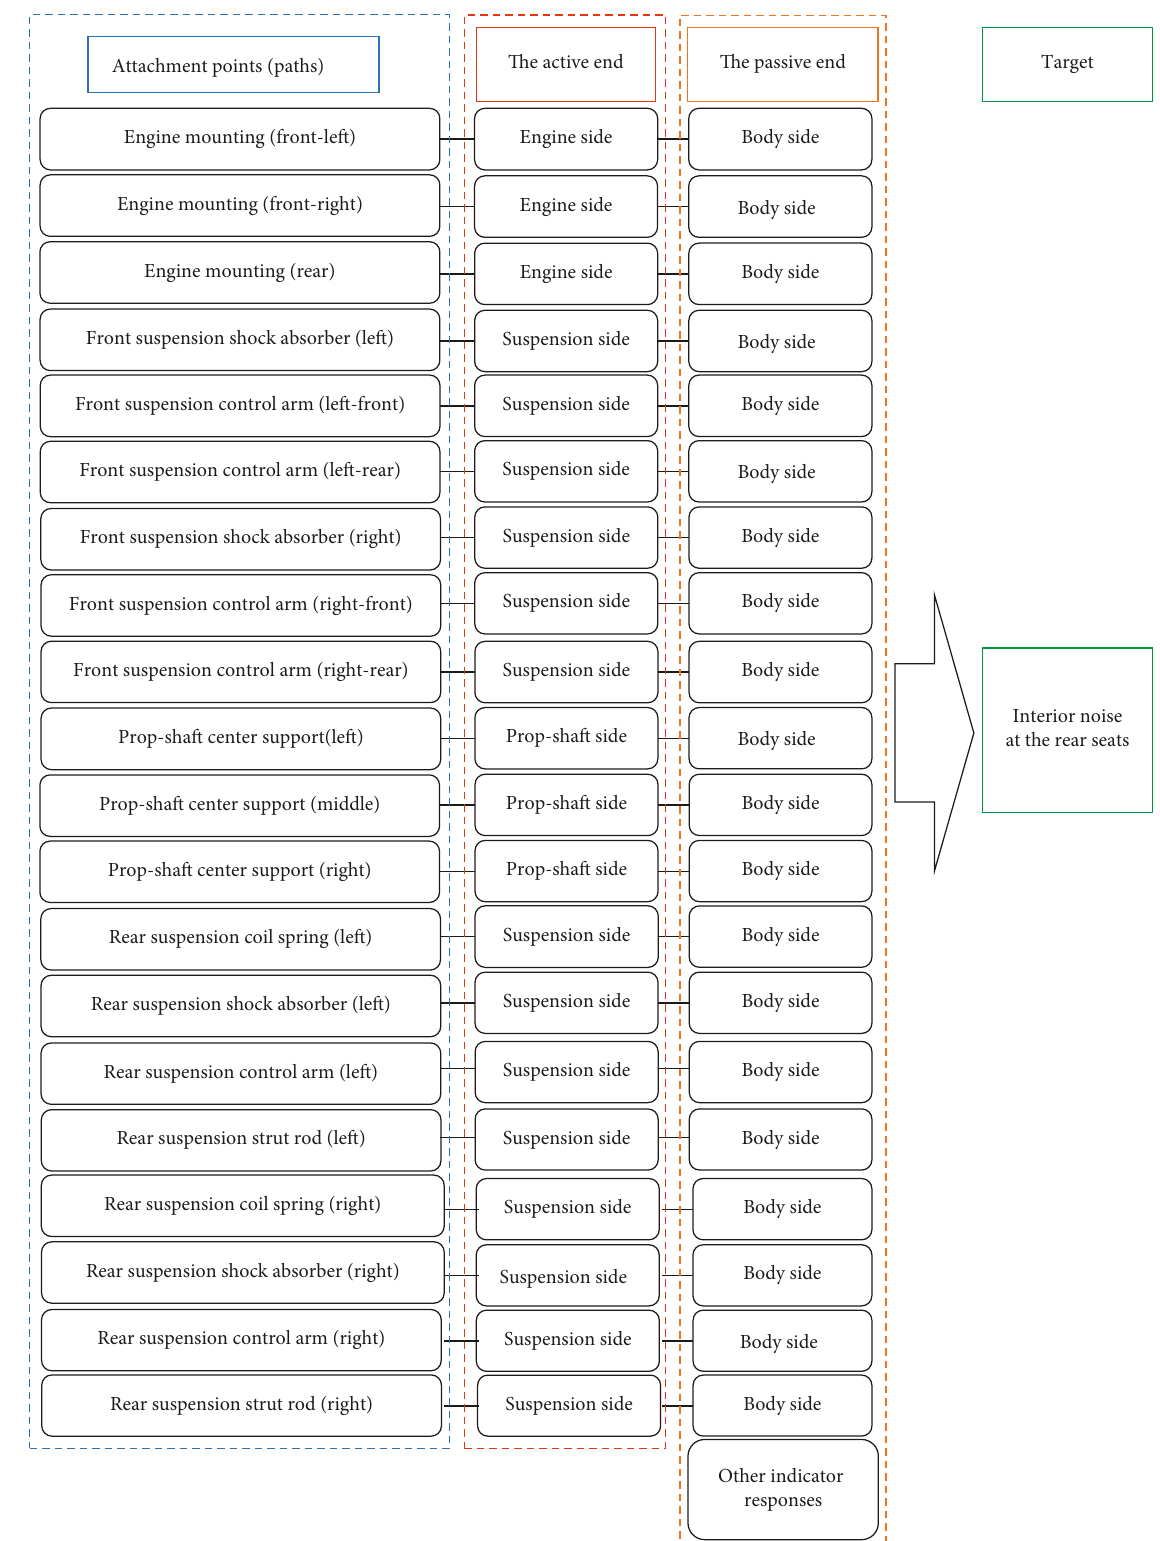
Figure 4: Scheme of the minivan internal booming noise TPA